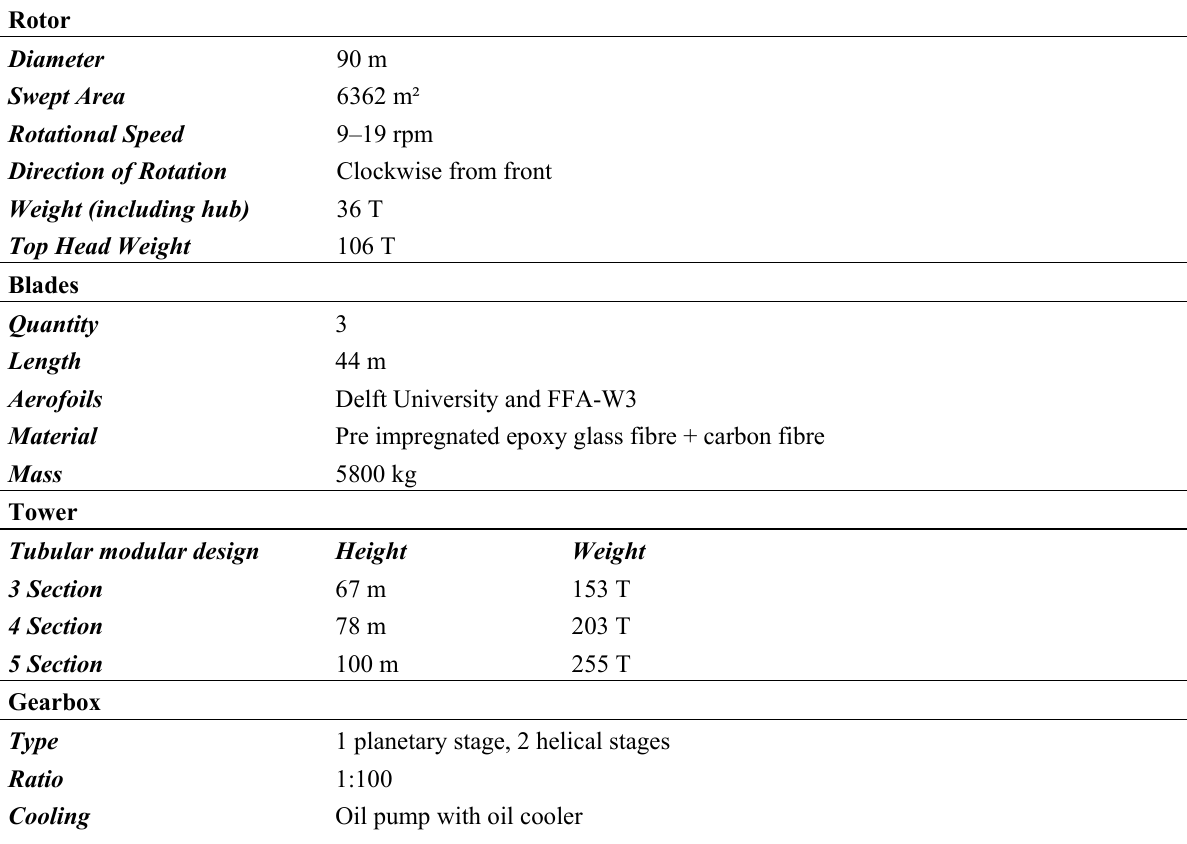
Table 5. A Typical modern 2MW wind turbine